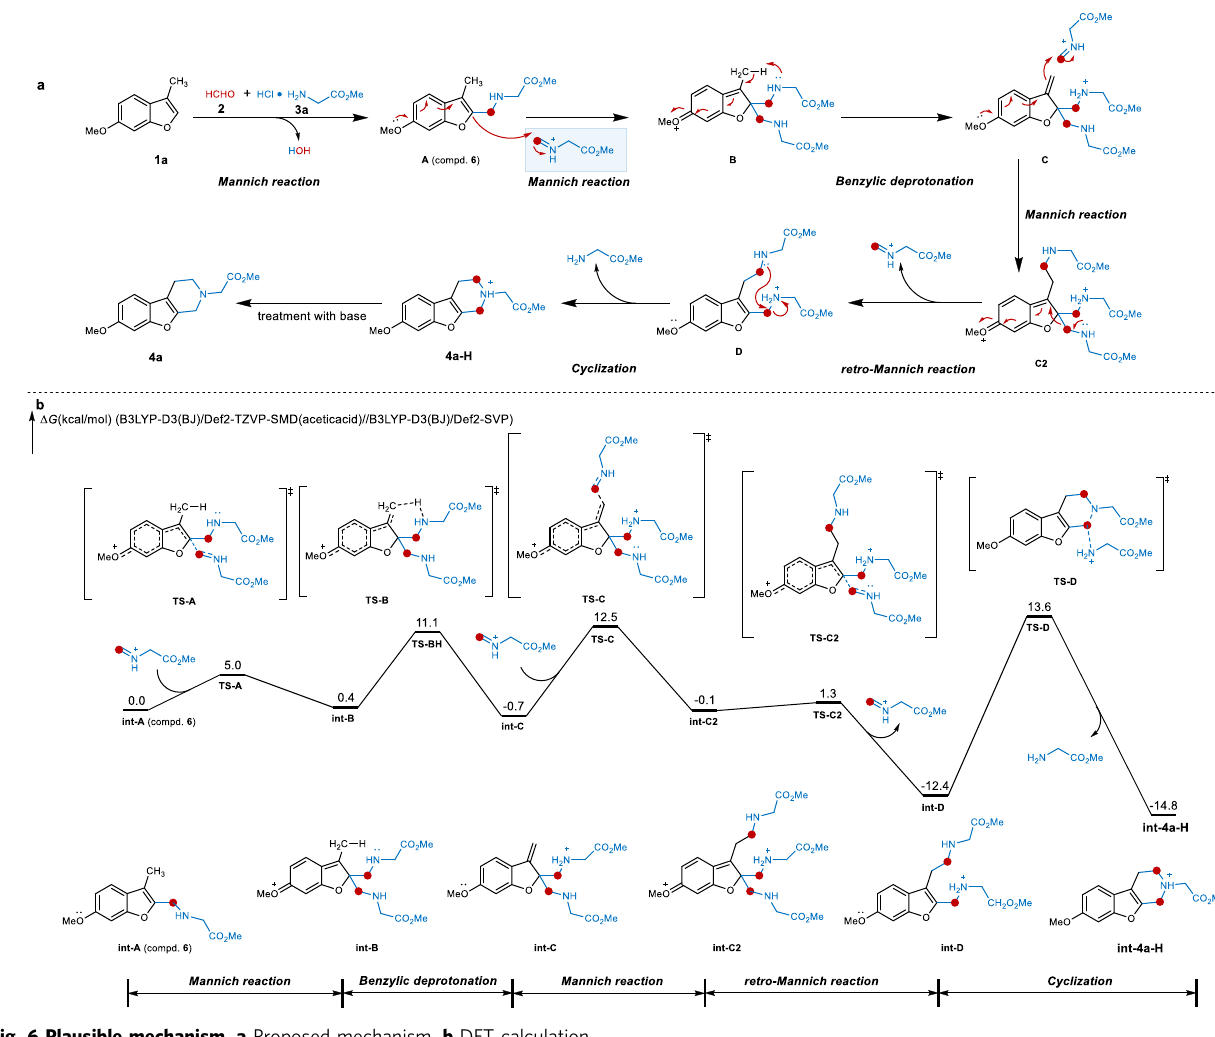
Fig. 6 Plausible mechanism. a Proposed mechanism. b DFT